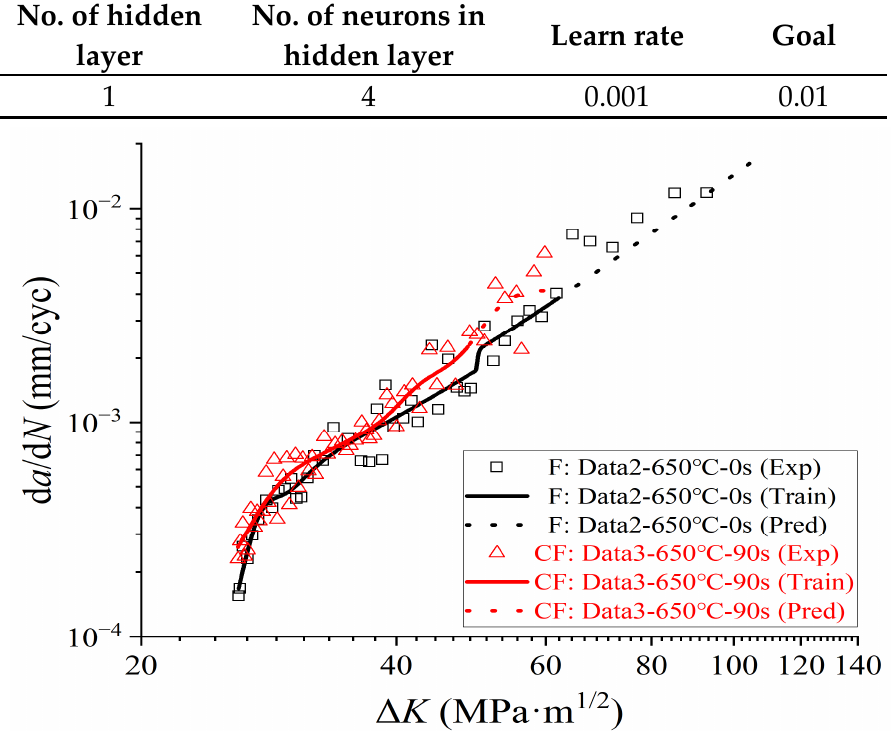
Figure 5. Prediction of the evolution of d a /d N with Δ K under fatigue condition (Data2–650 °C-0s- 18/0.9 kN) and creep-fatigue condition (Data3–650 °C-90s-18/0.9 kN).